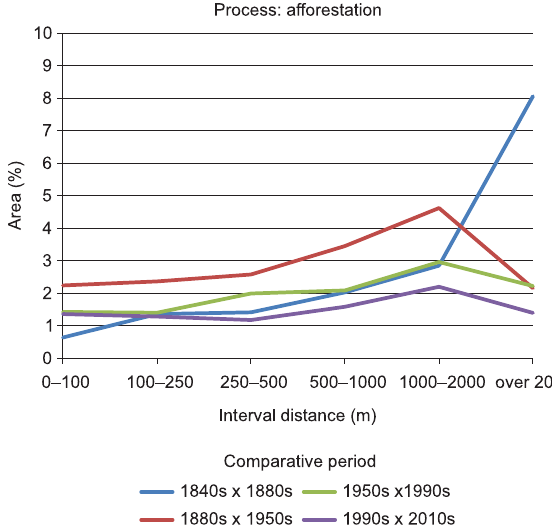
Fig. 11. Afforestation in the Hodonín region at various distances from existing roads.